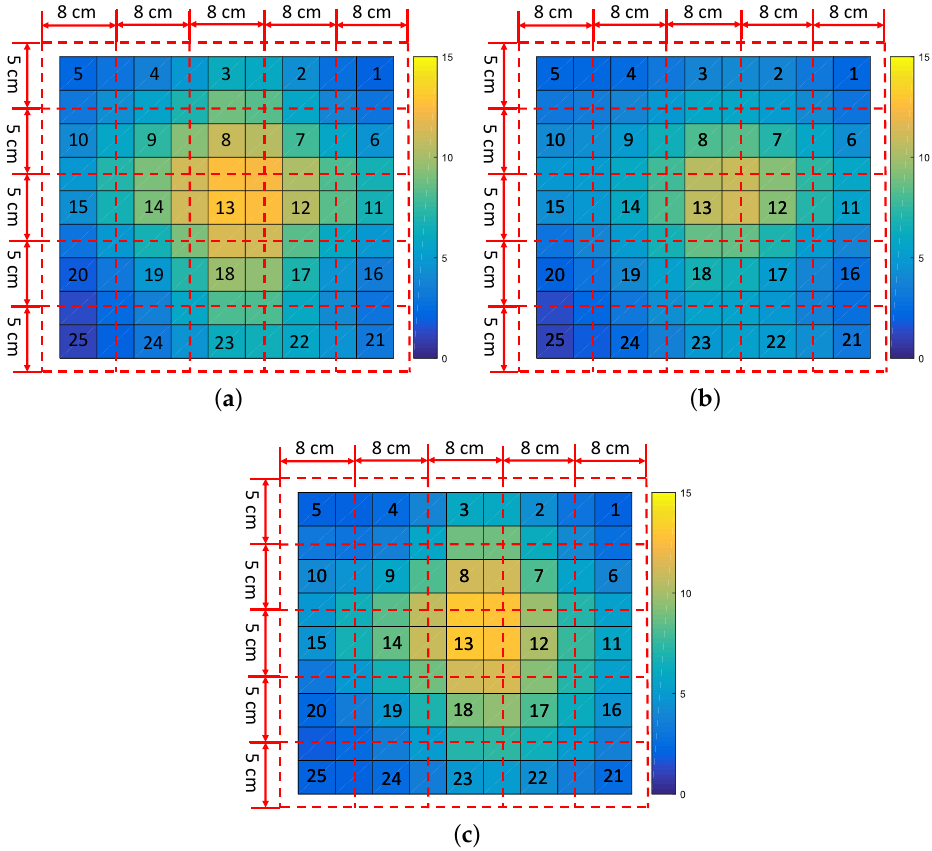
Figure 5. Noise reduction with the proposed active headrest without headtracking. Different colors indicate the amount of noise reduction: ( a ) noise reduction at left ear when the head has no rotation; ( b ) noise reduction at left ear when the head rotates leftwards 60 ◦ ; and ( c ) noise reduction at left ear when the head rotates rightwards 60 ◦